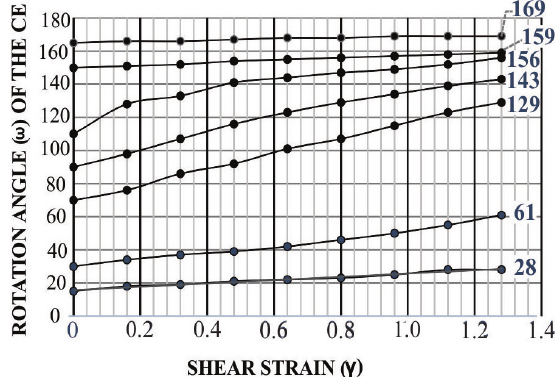
Figure 5 - Plots of the CE rotation angle (ω) during progressive deformation against shear strain